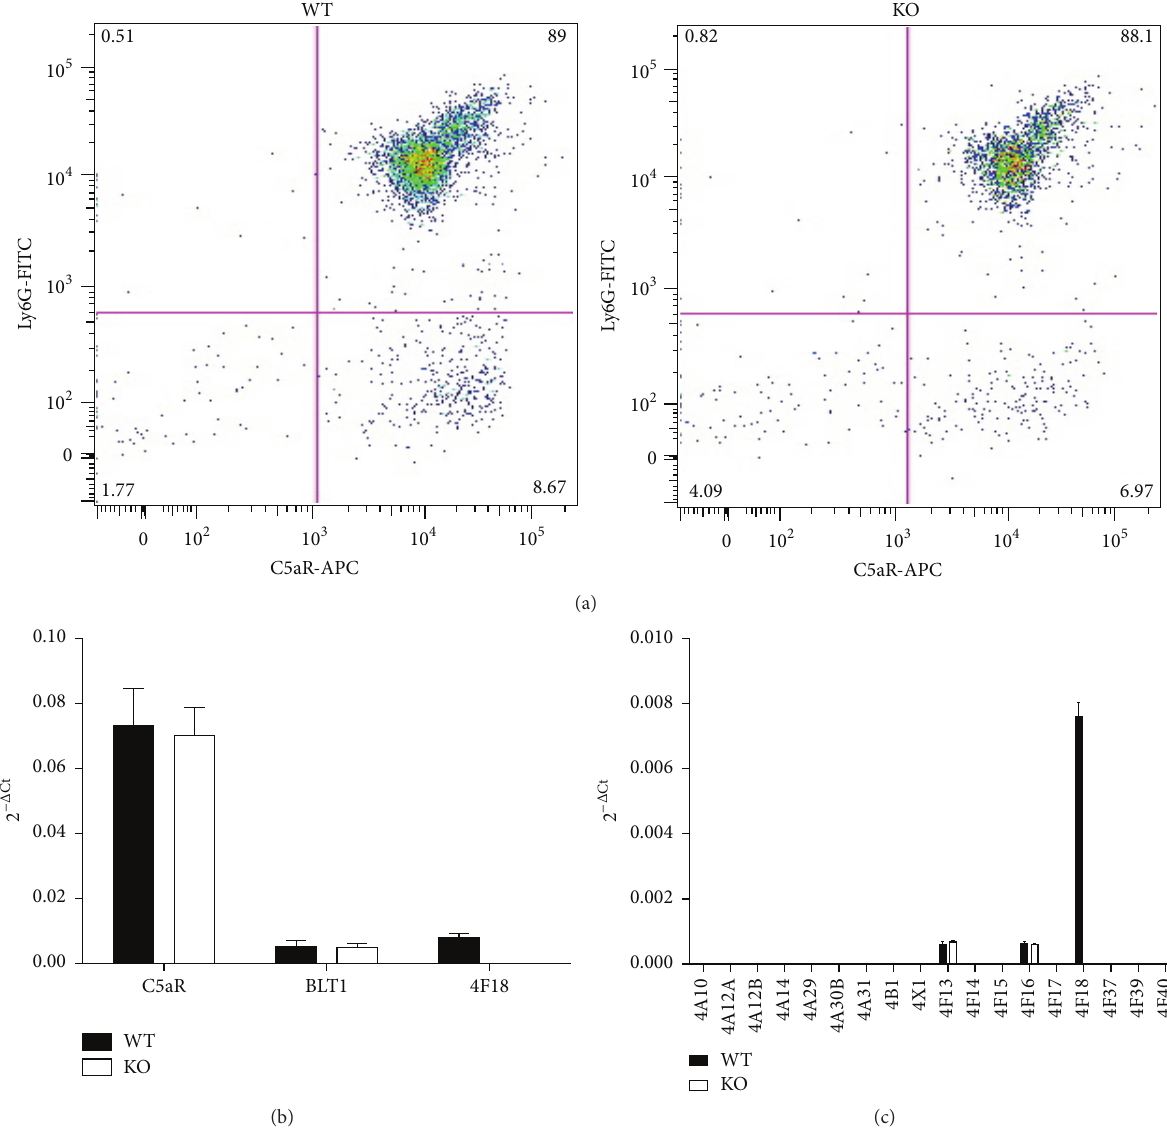
Figure 3: Gene expression in wild-type and Cyp4f18 knockout neutrophils. Flow cytometry analysis of bone marrow cells from wild-type (WT) and Cyp4f18 knockout (KO) mice using antibodies to Ly6G (neutrophil marker) and C5aR; representative double plots from individual mice are shown (a). Reverse transcription and real time PCR analysis of C5aR mRNA expression (b) and CYP4 mRNA expression (c), in isolated bone marrow neutrophils. Δ Ct values were determined for each transcript using GAPDH as endogenous control, and 2 −Δ Ct values were plotted for WT and KO samples ( 𝑛 = 4 ). Relative quantitation ( 2 −ΔΔ Ct ) determined that there was no significant change in expression of any of the transcripts tested in knockout samples compared to wild-type, except for the loss of